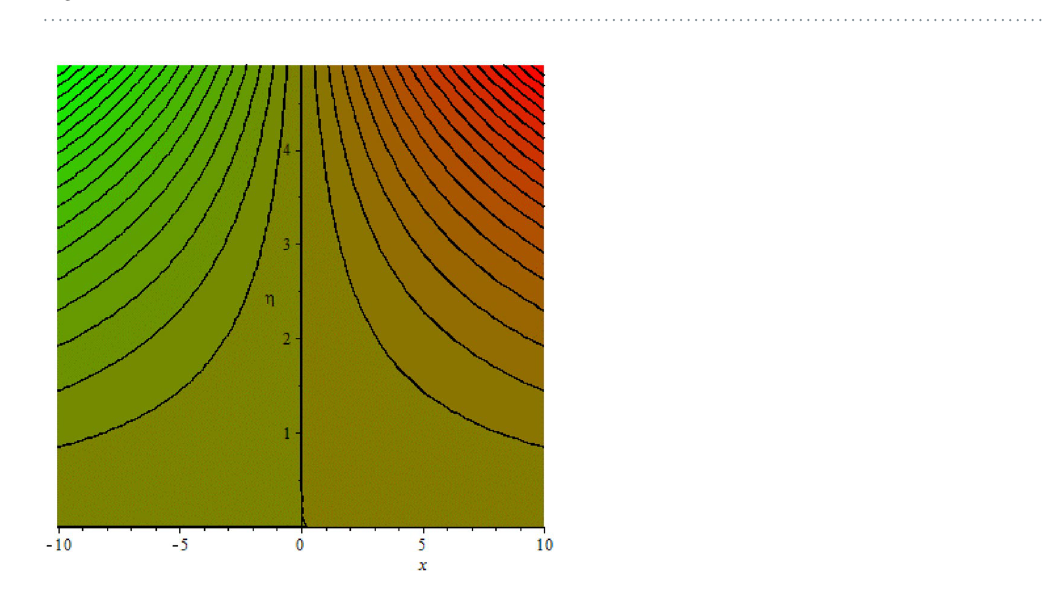
Figure 7. Stream lines when γ = 0.0 and A = 0.5.